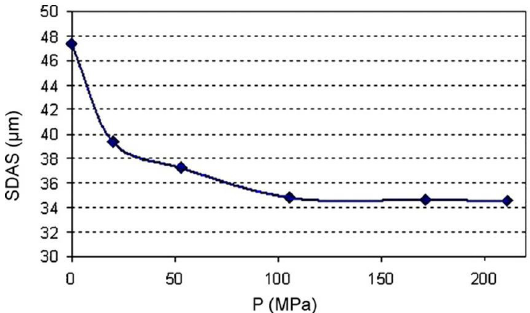
Figure 9. Secondary dendritic arm spacing of LM13 aluminum alloy 12 .